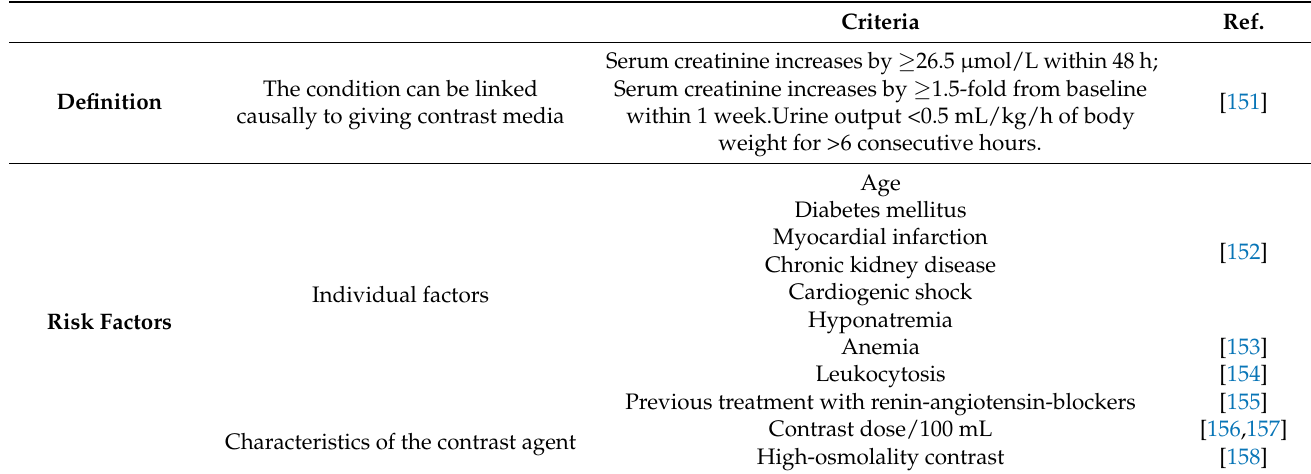
Table 4. Definition and risk factors of post contrast AKI. Criteria